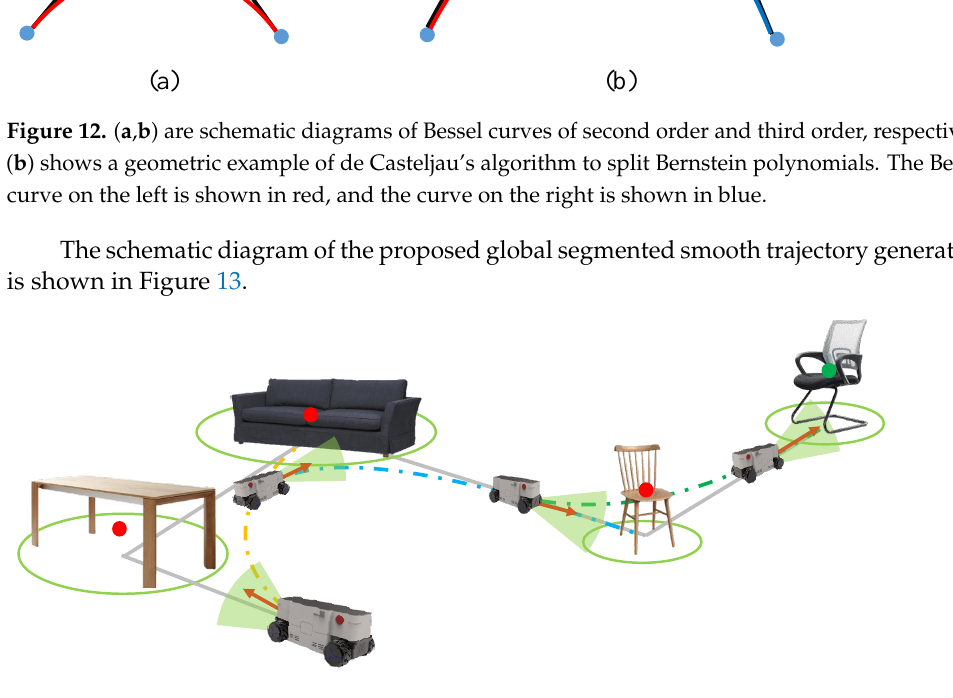
Figure 13. The schematic diagram of the proposed global segmented smooth trajectory generation. The gray solid line is the global topology shortest path. The three dashed lines (yellow, blue, and green) are the three trajectories generated online, respectively. Each segment of the trajectory is a Bessel curve generated by taking the robot’s rigid body as the starting control point and the first currently invisible node in the one-way diagram as the end control point in